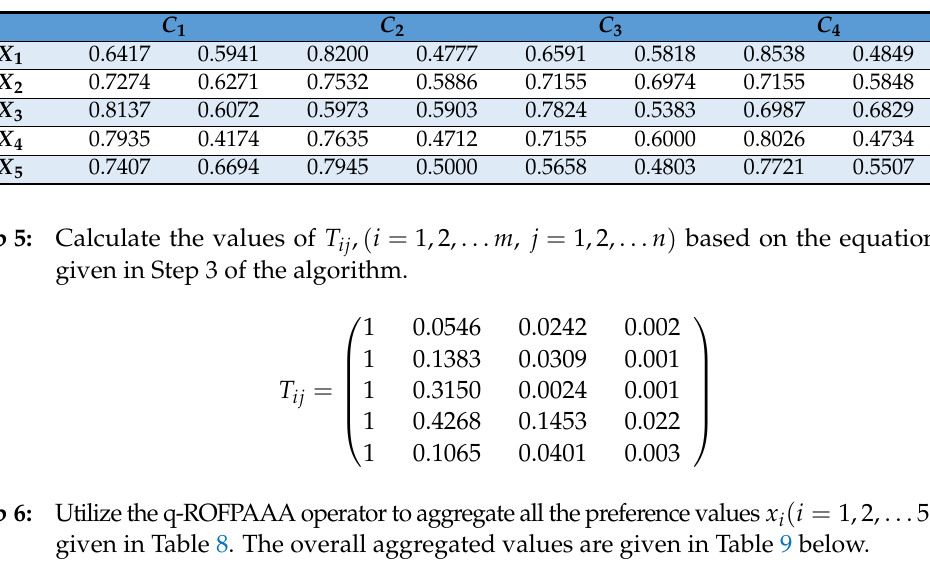
Table 9. Collective preference information.